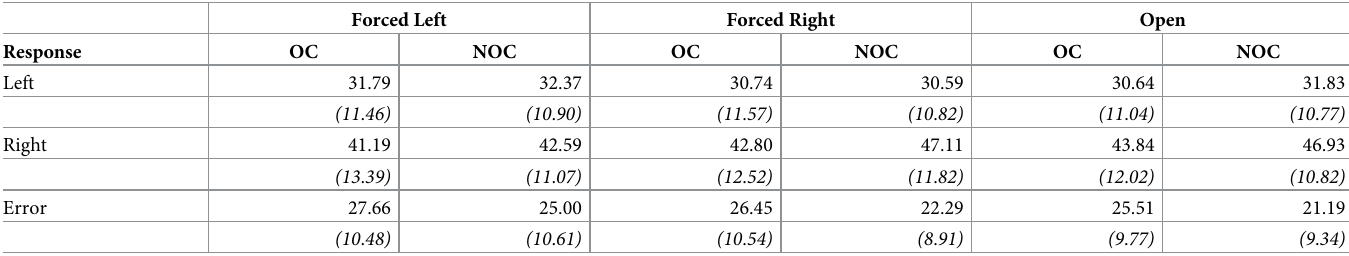
Mean values are in Roman and standard deviations are in parentheses and